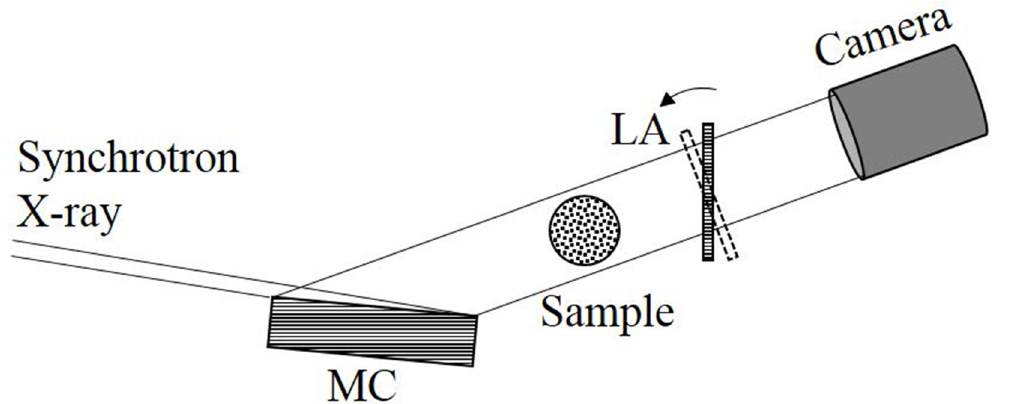
Fig 2. Schematic representation of the XDFI